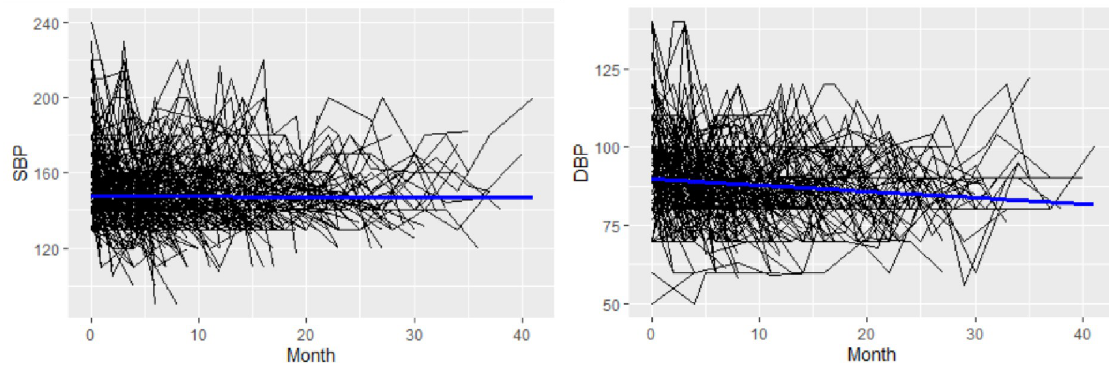
Fig 3. Individual profiles with average trend line for SBP and